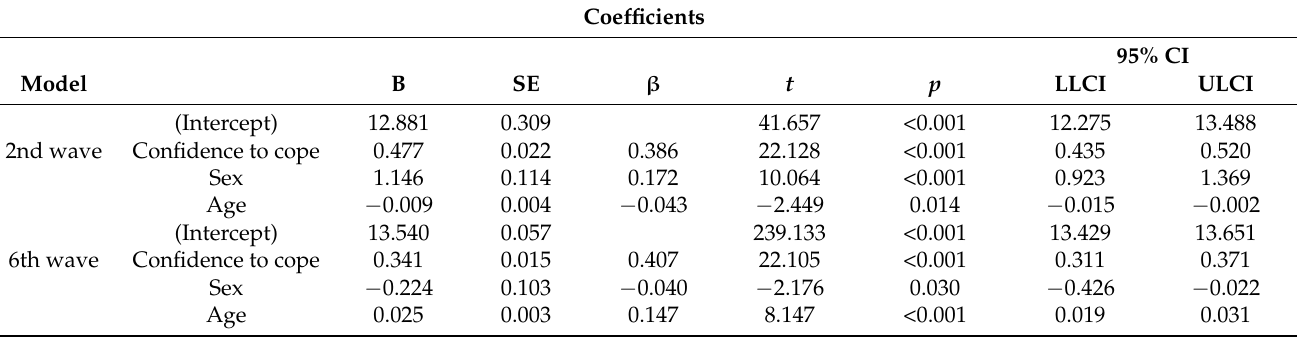
Figure 3. Pearson’s coefficient correlation heat map across the 2nd and 6th waves in Spain. Note; *** p < 0.0001. A linear multiple regression was carried out (see Table 2) for the 2nd and 6th waves. Thus, age, confidence in coping with COVID-19 and sex (considered as a dummy variable) were entered as the predictors, and the outcome variables was positive mental health. Table 2. Variables included in the linear regression model for the 2nd and the 6th waves. Sex was included as a dummy variable. Standard error = SE; Unstandardized = B and Standardized = β . Lower and upper confidence interval (LLCI and ULCI) level .